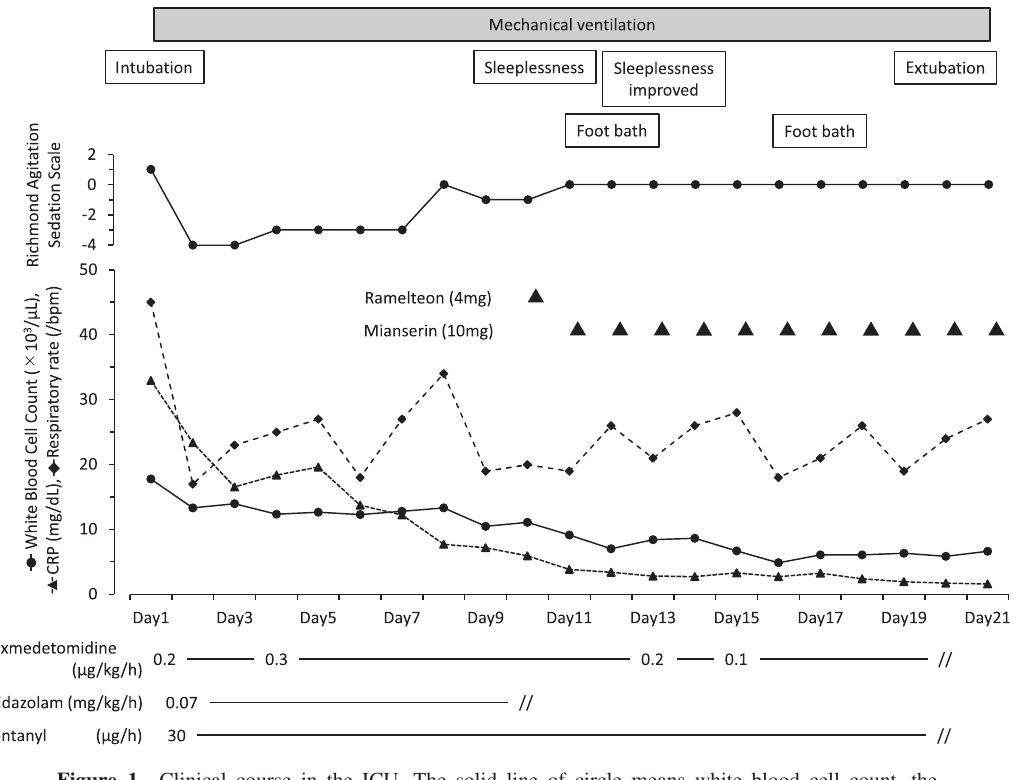
F i g ure 1 Clinical co u rse in the ICU. The solid line of circle means w hite blood cell co u nt, the dashed line of trian g le means CR P and the broken line of rhomb u s means respirator y rate. From da y 1 to da y 21, she recei v ed mechanical v entilation s u pport and from da y 1 to da y 10 she w as sedated w ith dexmedetomidine, midazolam and fentan y l. After discontin u ed midazolam administered, she com- plained sleeplessness and ramelteon nor mianserin co u ld impro v e her sleeplessness. After foot bath